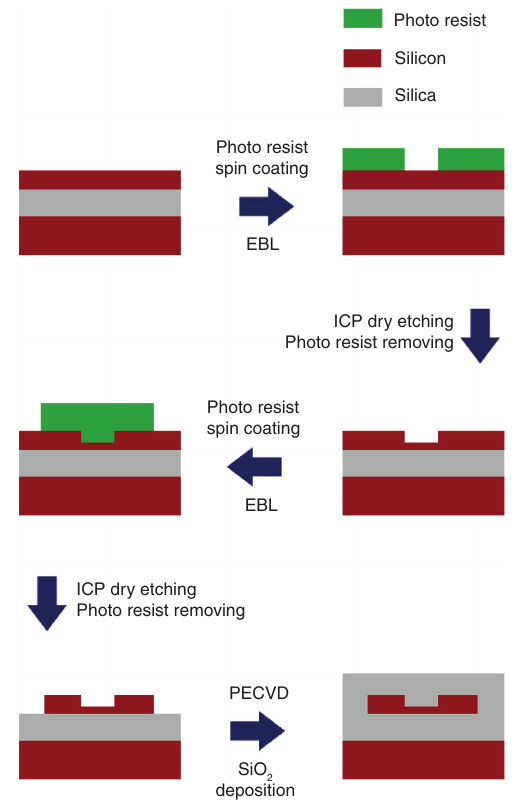
Figure 2: Schematic diagram of the fabrication process of subwavelength structured silicon